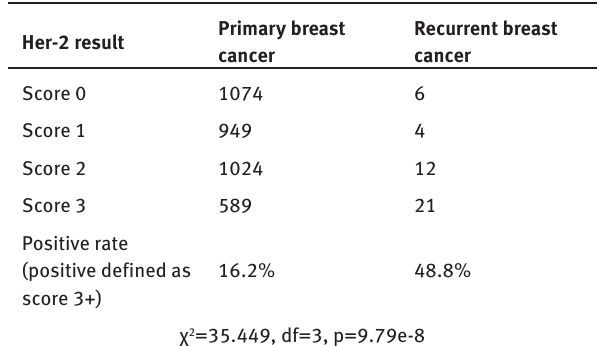
Table 3: Difference in PR expression between primary and recurrent breast cancer.